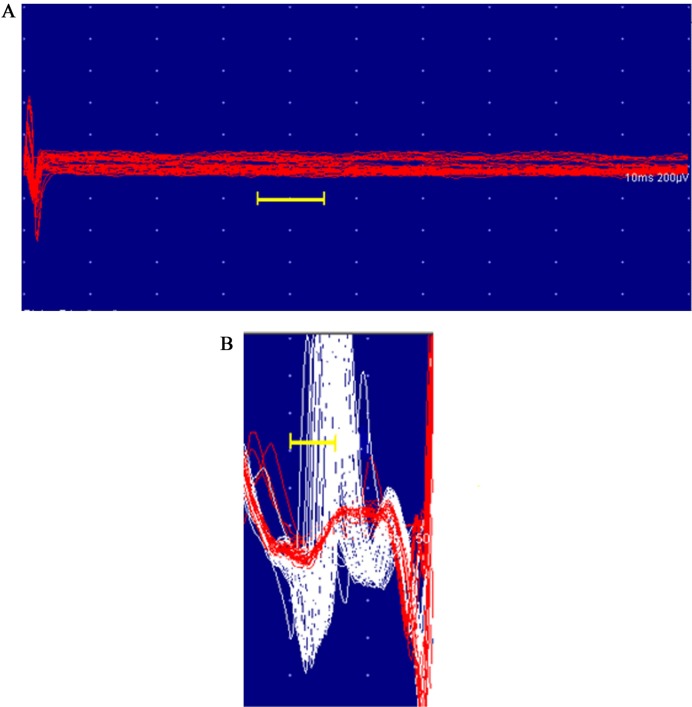
SfEMG tracings of blocking.A. Complete blocking of the neuromuscular junction seen in SfEMG; B. Incomplete blocking: white coloured SfEMG tracings represent the fibres with increased jitter and red coloured fibres present blocking.